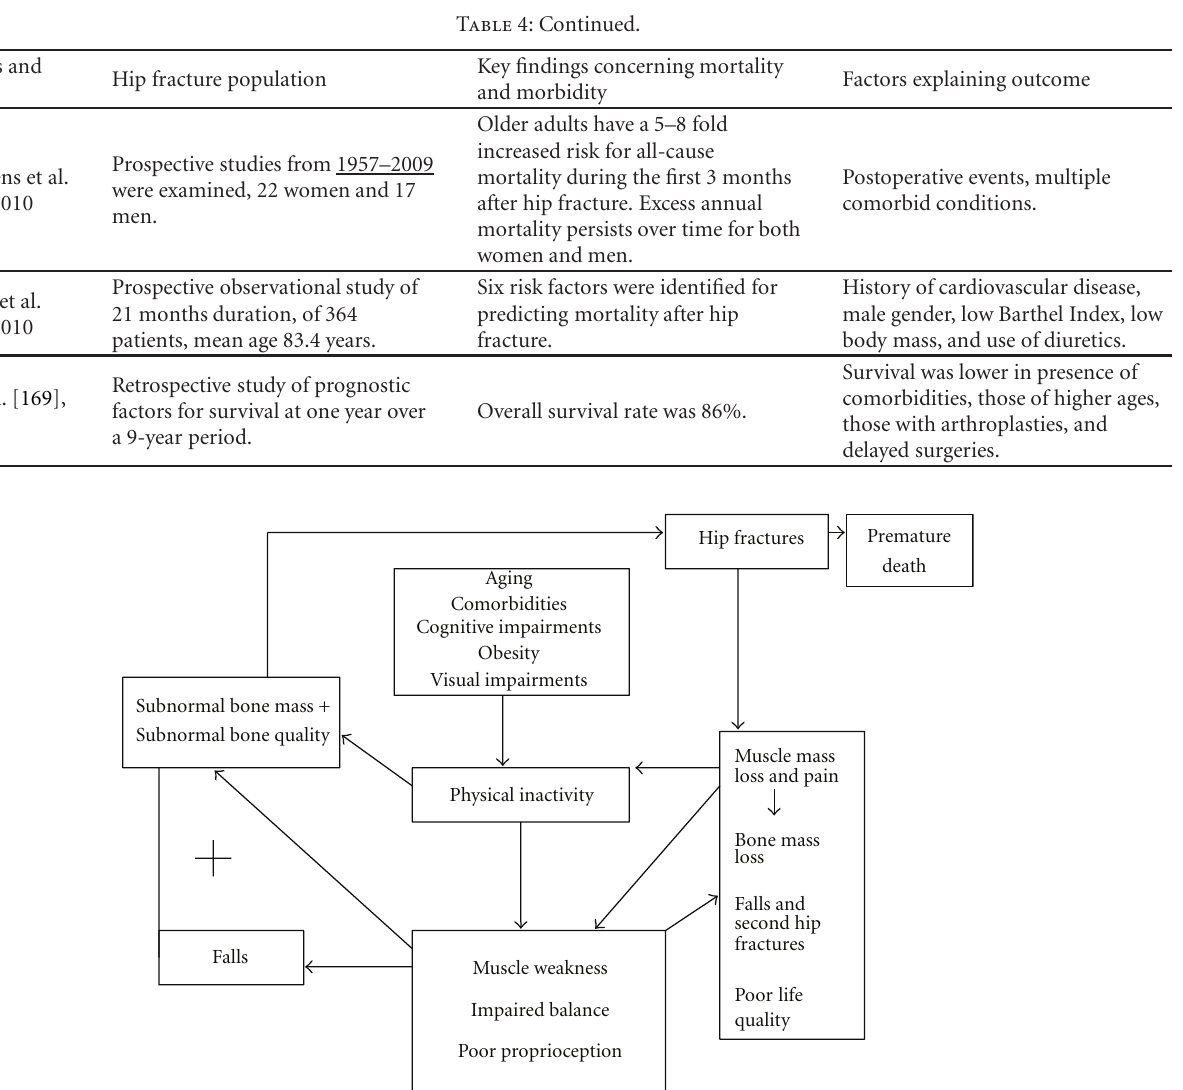
Figure 1: Model of key factors implicated in hip fracture